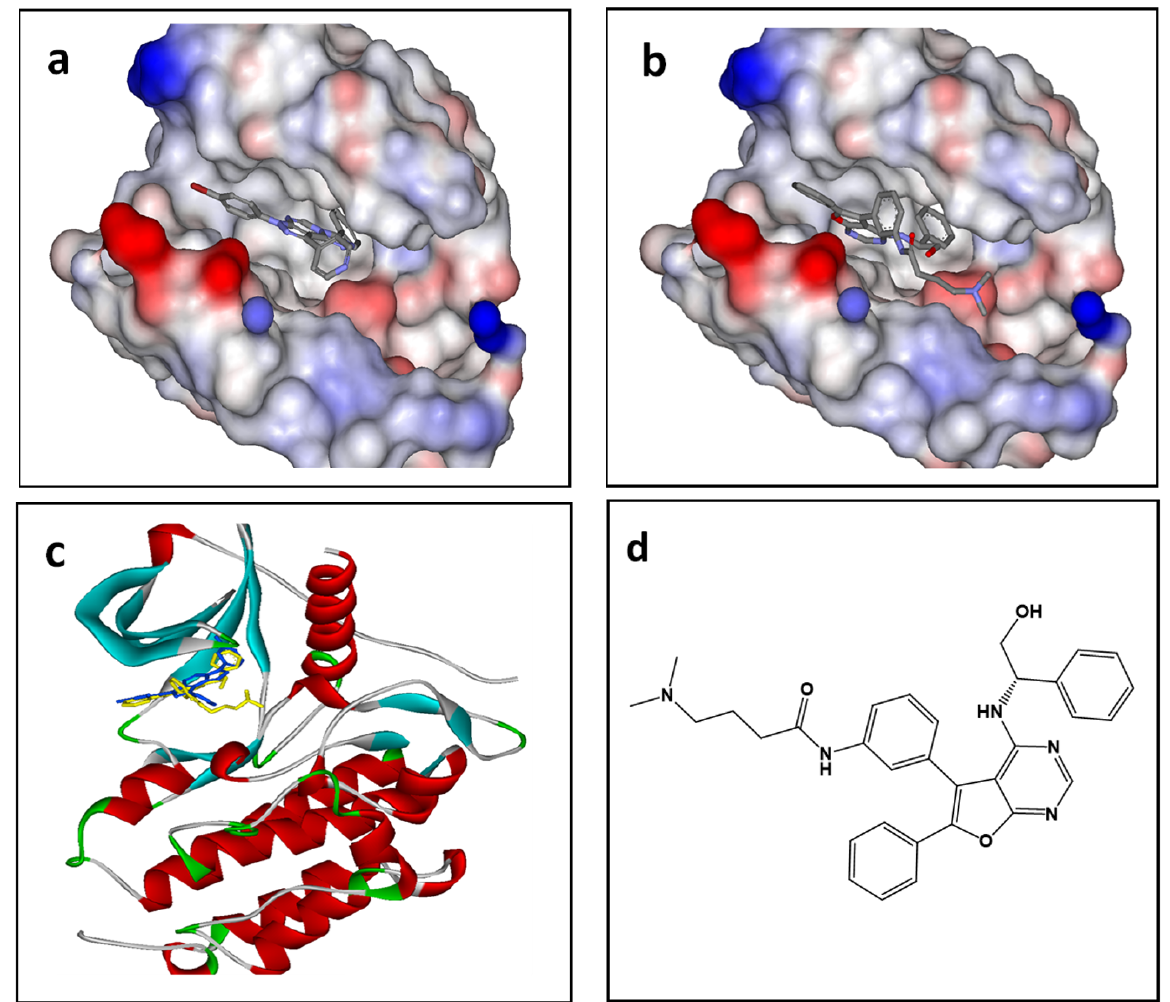
Figure 4. Solvent-accessible surface area of the active site of EGFR crystal structure 4JRV (Rs = 2.8 Å) containing the docked pose of pyrazoltriazolopyrimidine derivative 1 ( a ); and the co-crystallized inhibitor (furopyrimidine derivative) ( b ); ribbon diagram of docked pose of pyrazoltriazolopyrimidine derivative 1 (blue) superimposed on the co-crystallized ligand (yellow) ( c ); the structure of the furopyrimidine co-crystallized inhibitor ( d ).